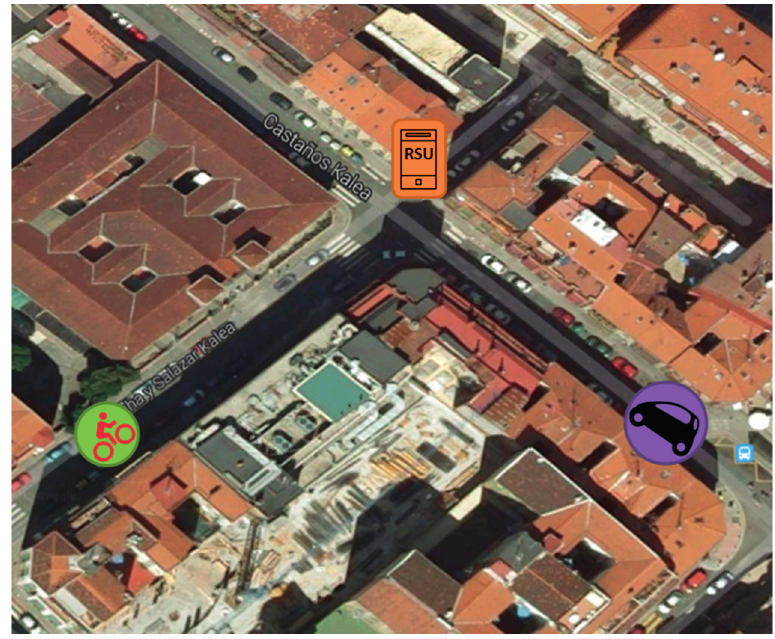
Figure 13. V-Alert testing scenario in the city of